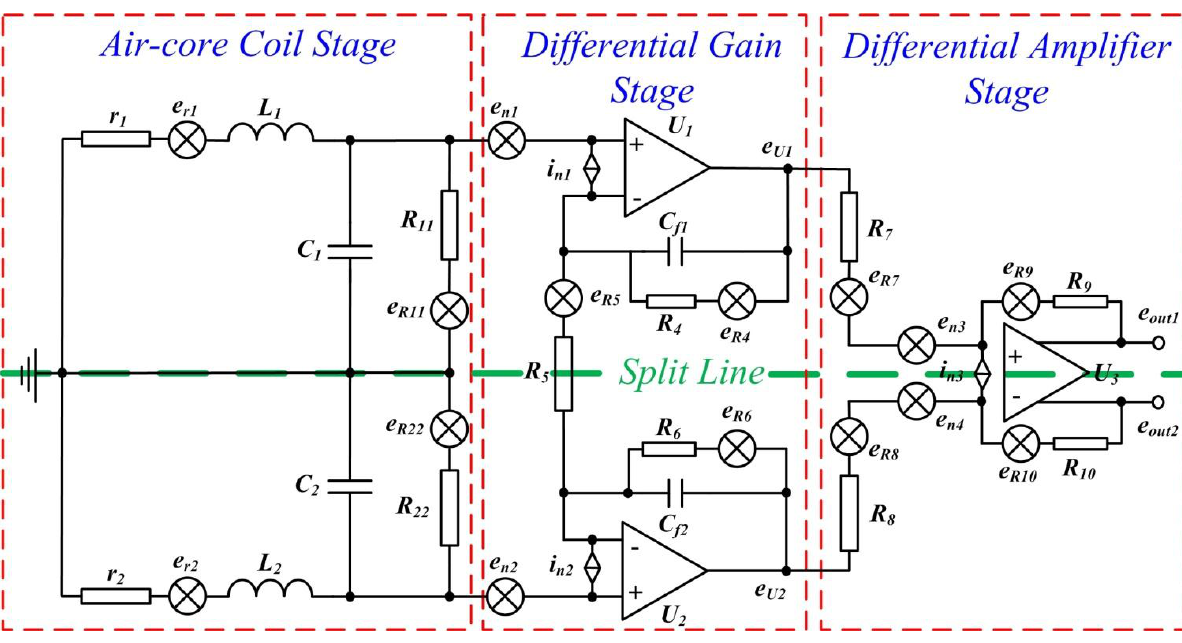
Figure 3. ACS circuit with equivalent noise